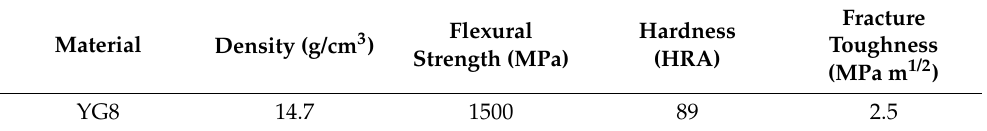
Table 1. Mechanical property of cemented carbide insert.